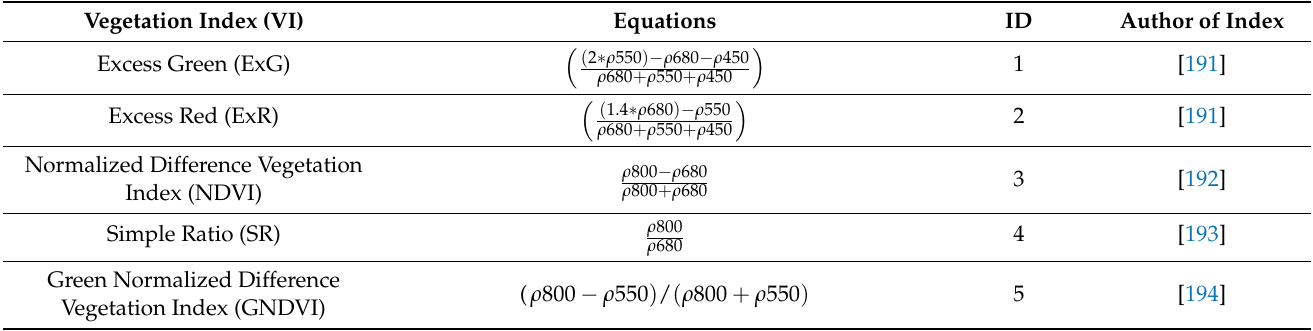
Table 2. The most calculated vegetation indices (VI) for viticulture